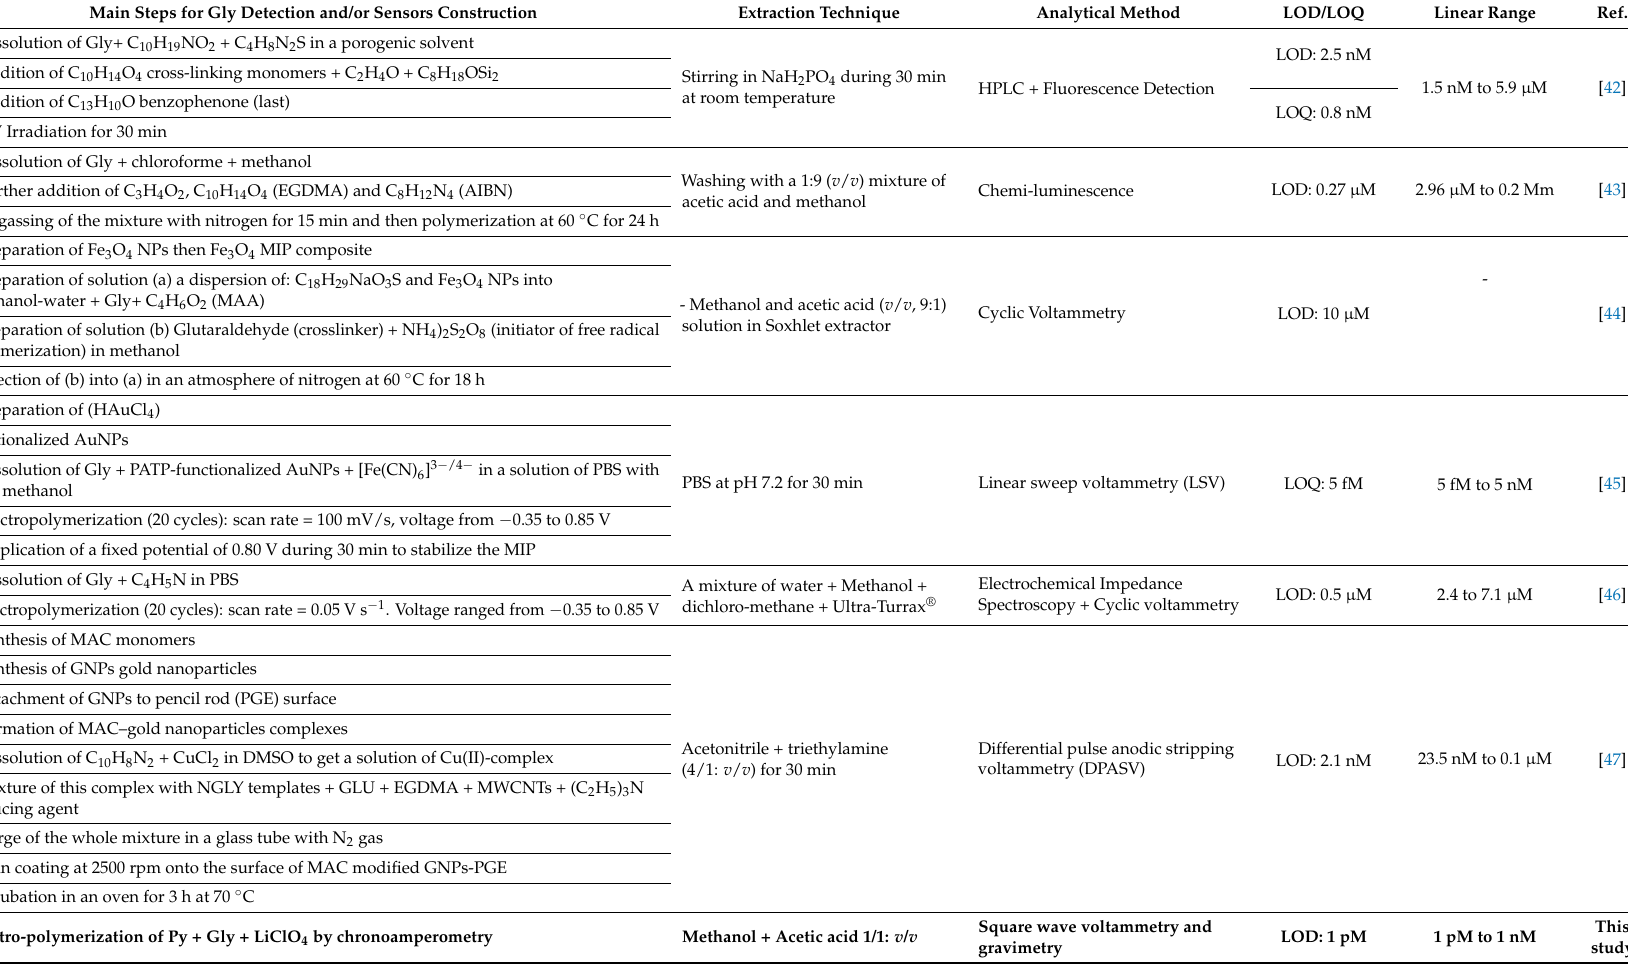
Table 2. Examples of MIP-based sensors for Gly